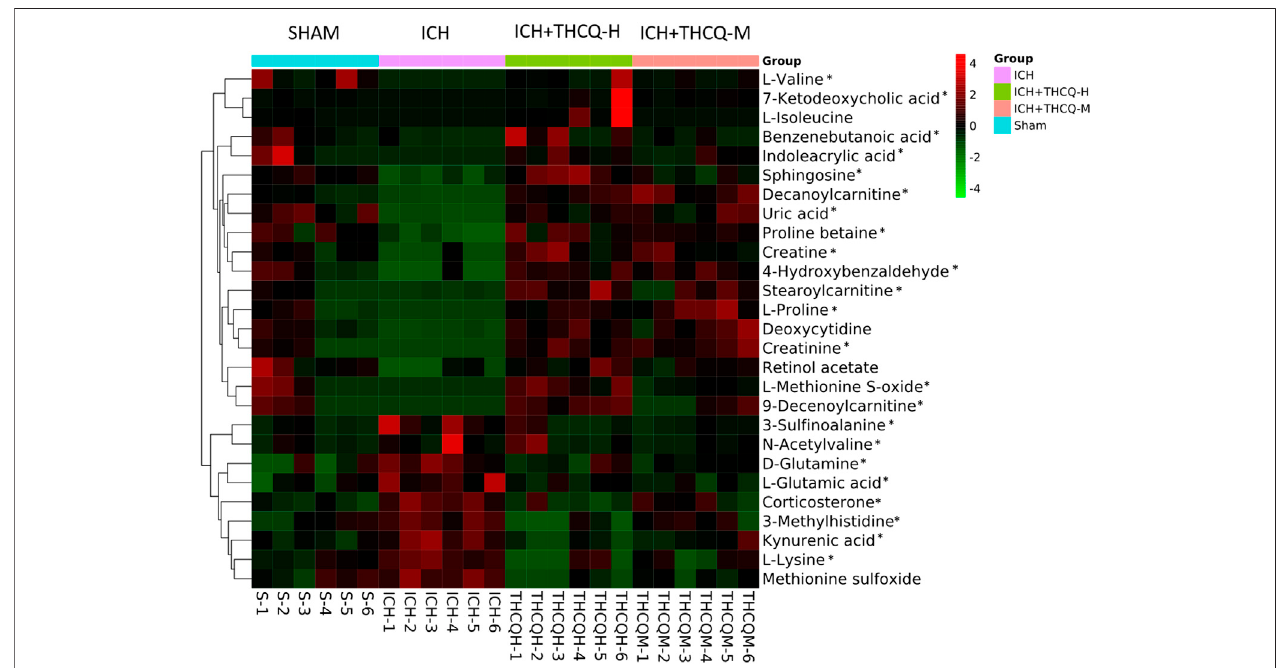
FIGURE7| Heatmap of27serum metaboliccandidate biomarkersineach sample.Serum levels ofthe27metabolites werestriking increasedbyadministration of THCQ decoction atahigh-dose(THCQ-H)inthesham,ICH, ICH+THCQ-H, andICH+THCQ-Mgroups(n (cid:2) 6pergroup). *Serummetabolitessigni fi cantlychangedby THCQ decoction administration at a medium-dose